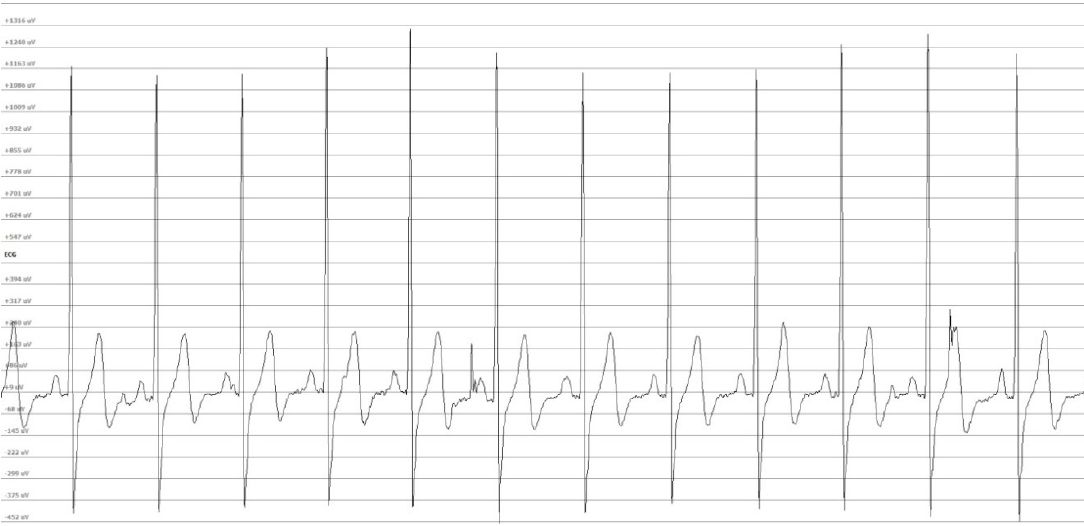
Figure 1. Example for an electrocardiography (ECG) signal recorded during unattended monitoring in a home